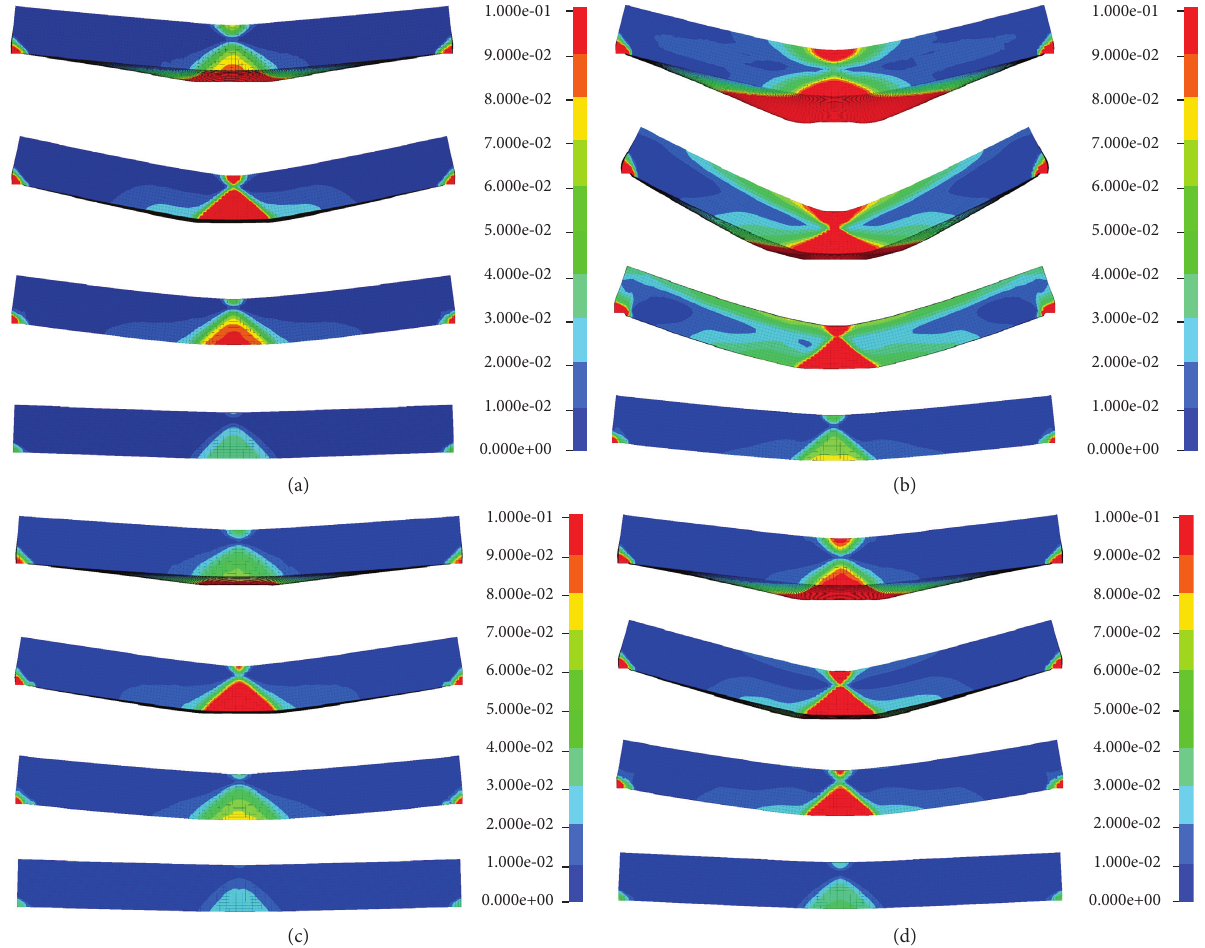
Figure 5: Plastic strain distribution in (a) chuanshan limestone, (b) gaolishan sandstone, (c) mineralized limestone, and (d) xixia limestone panels after blast loading. In each subplot, the standoff distance from the top to bottom is 0.15m/kg 1/3 , 0.30m/kg 1/3 , 0.60m/kg 1/3 , 1.20m/kg 1/3